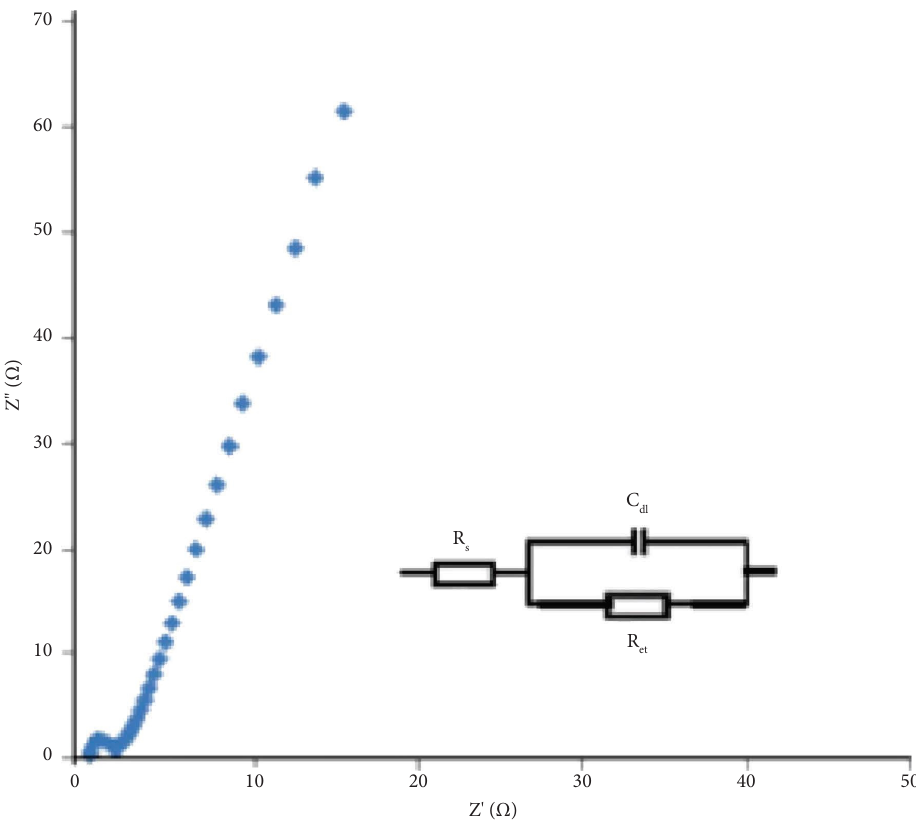
Figure 10: EIS spectrum of the Co(OH) 2 electrode sample [118]. Table 3: General comparison of supercapacitor and lithium-ion Table 2: Comparison of conventional capacitors, supercapacitors, battery and batteries [131].